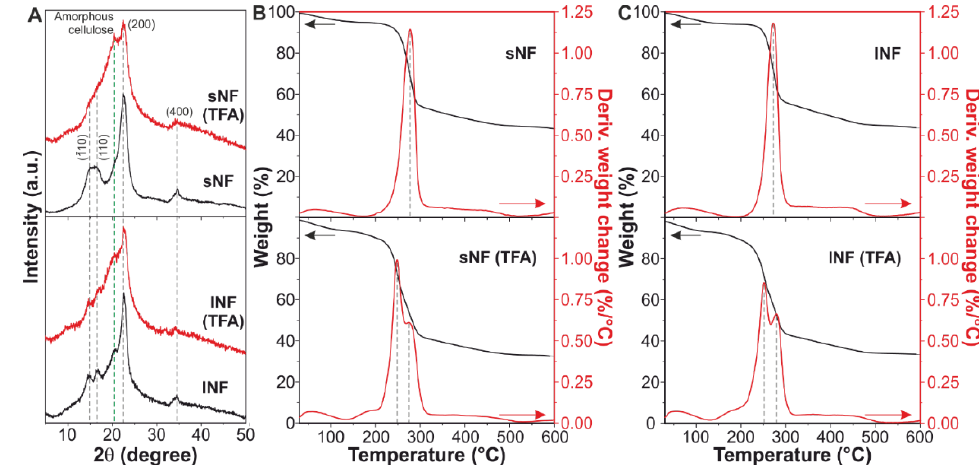
Figure 2. (A ) X-ray diffraction (XRD) patterns of sNF and lNF before and after the trifluoroacetic acid/trifluoroacetic acid anhydride (TFA/TFAA) treatment. Main assignments are included. ( B , C ) Thermogravimetric analysis (TGA) curves and their corresponding derivatives of sNF and lNF, respectively, before and after the TFA/TFAA treatment.